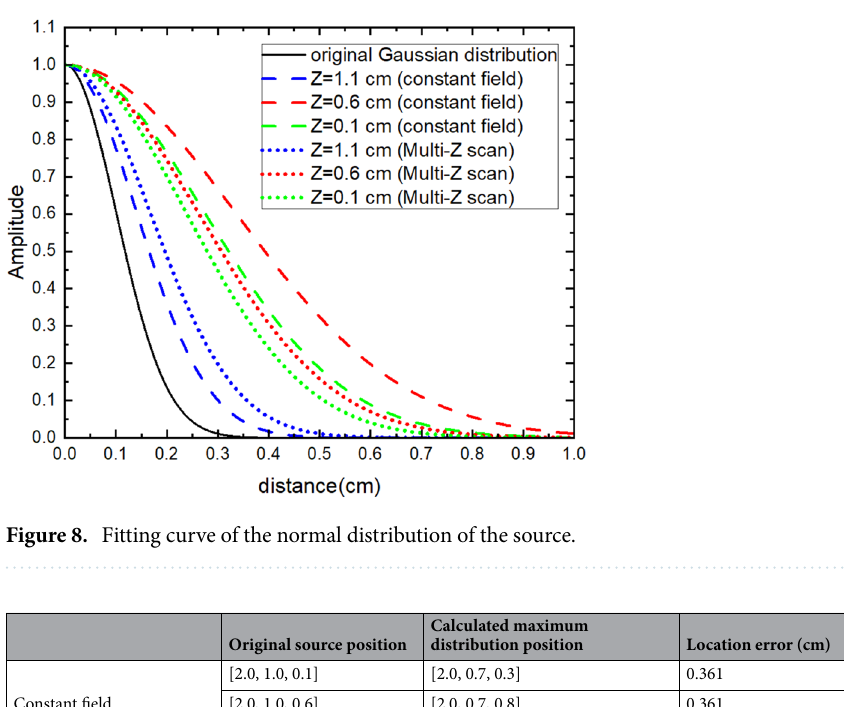
Original source position